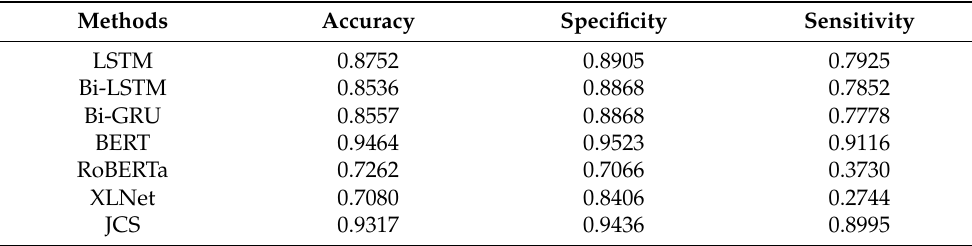
Table 2. Comparison between our model and previously proposed